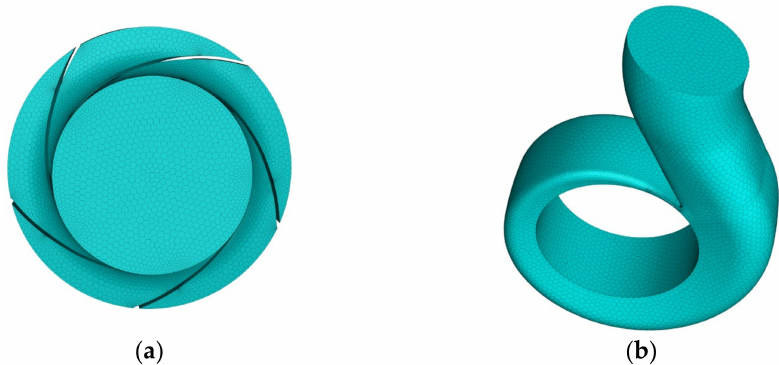
Figure 3. Centrifugal pump grid diagram: ( a ) impeller; ( b )